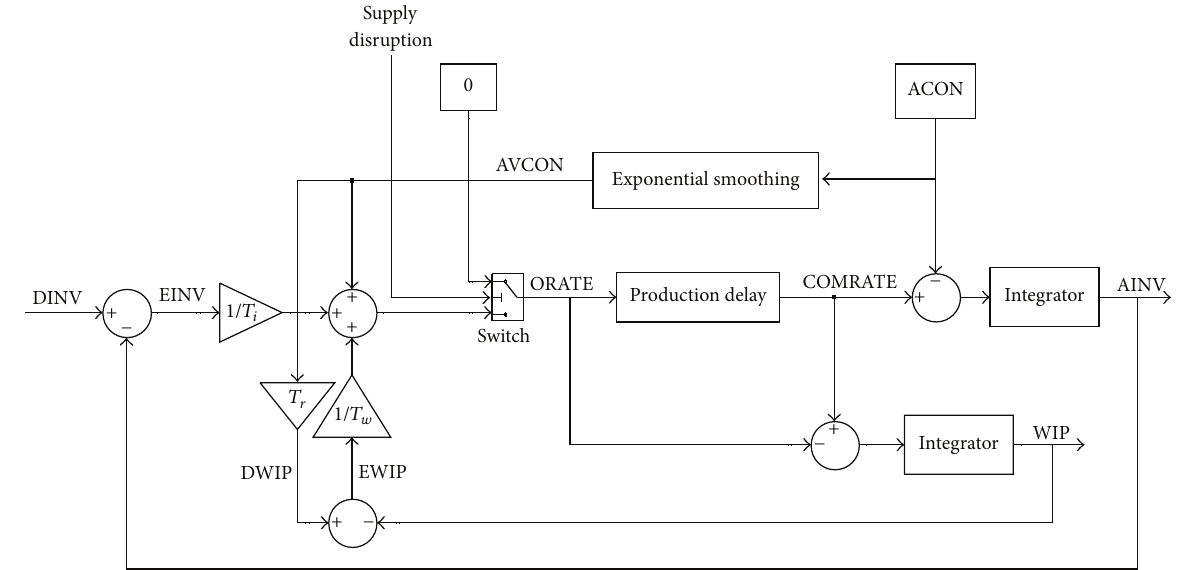
Figure 2: Block diagram of the APIOBPCS under supply and demand